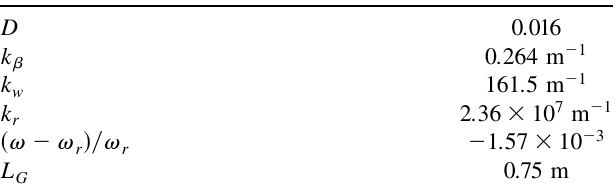
TABLE IV. Typical FEL parameters from analytical calculation.